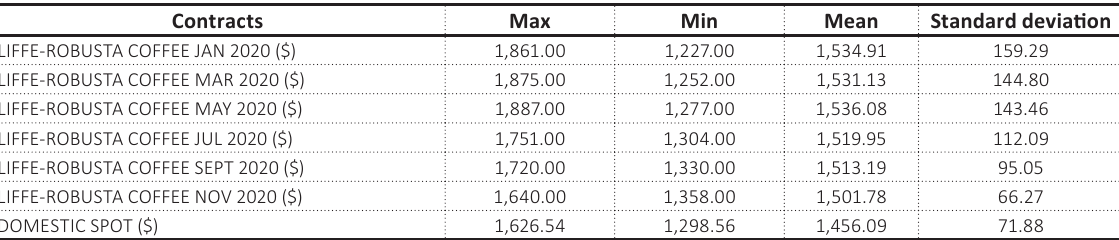
Table 4. Statistics of data on futures prices and spot prices of Robusta coffee Source: Authors’ calculation based on data collected from Thomson Reuters Datastream.